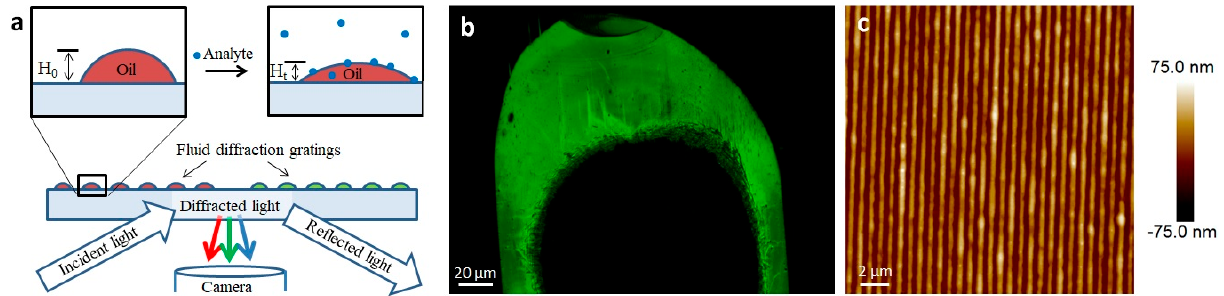
Figure 6. Lipid multilayer gratings. ( a ) Schematic showing the assay of exposing lipid multilayer gratings to an analyte while monitoring the diffraction from the arrays. ( b ) An example of an optical image of a DOPC-based lipid multilayer grating taken according to the setup shown in ( a ). ( c ) AFM image of a DOPC lipid multilayer grating.